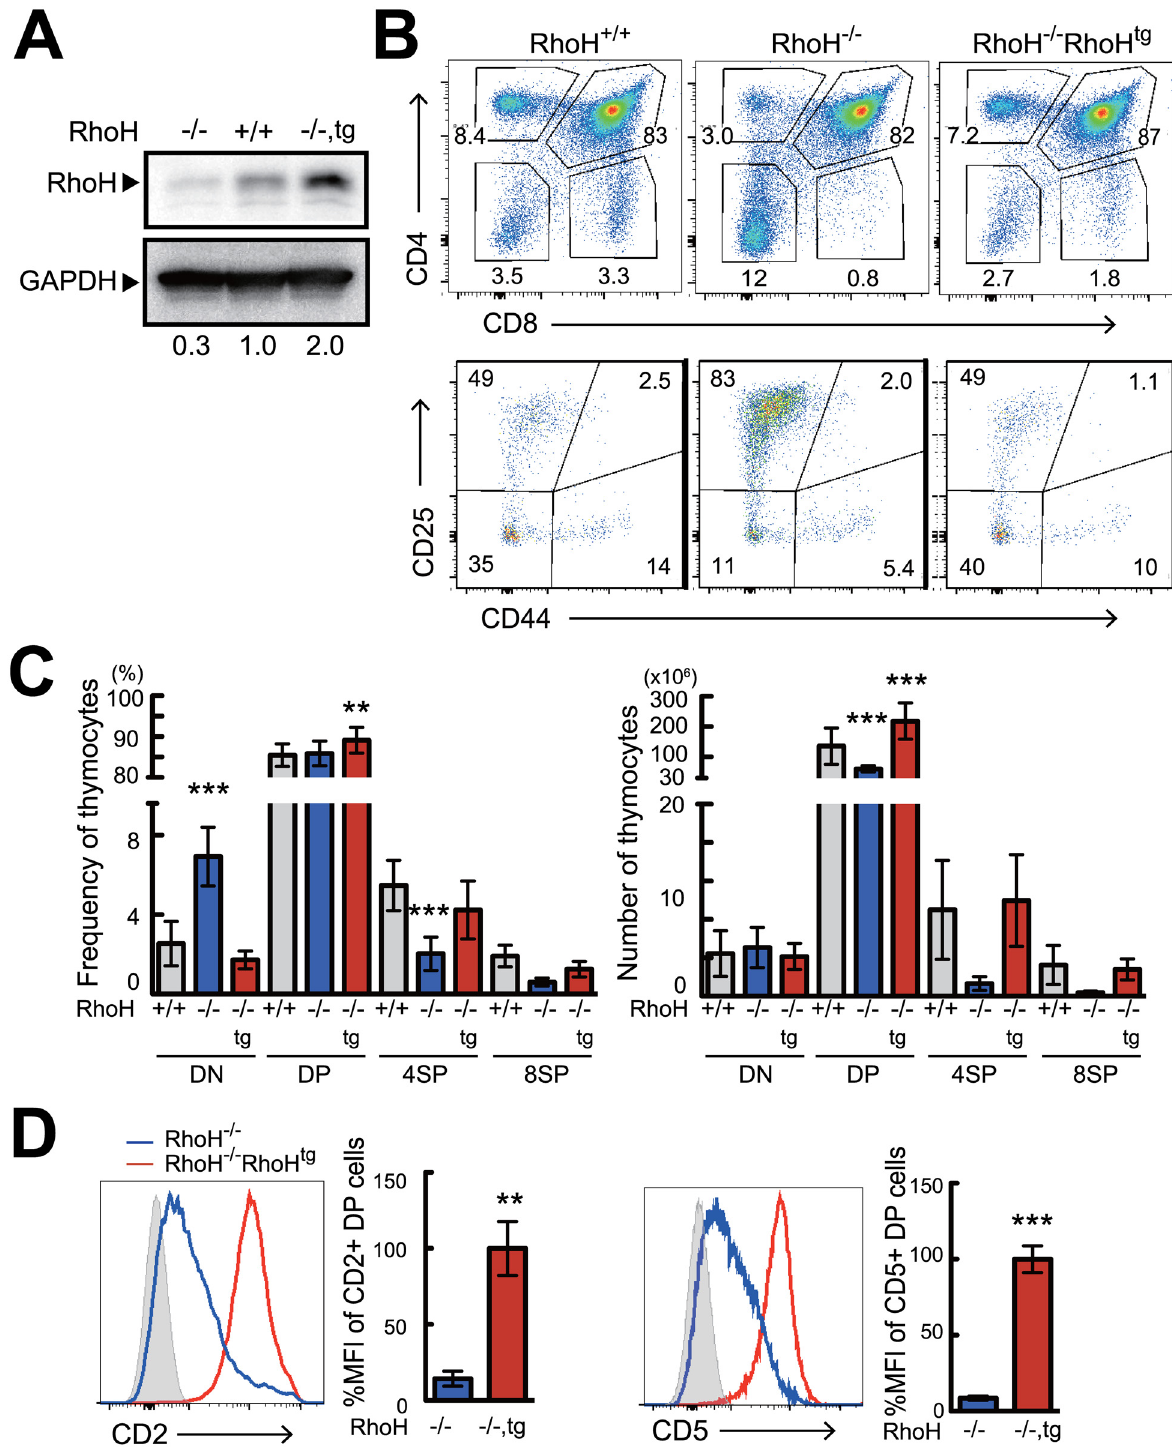
Fig 1. The transgenically expressed HA-tagged RhoH is capable of compensating T cell development in RhoH -/- mice. (A) Analysis of RhoH protein expression by western blot in RhoH -/- , RhoH -/- RhoH Tg , and RhoH +/+ thymocytes. (B, C) Analysis of RhoH -/- , RhoH -/- RhoH Tg , and RhoH +/+ thymocytes by flow cytometry. Two parameter plots show CD4 versus CD8 surface staining of thymocytes (upper), and CD25 versus CD44 surface staining on CD4 - CD8 - (DN) cells (lower). Numbers indicate percentage of cells in the selected area. Bar graphs represent average cell number and frequency of indicated thymocyte subsets calculated from six mice per group. (D) Single parameter histogram plots show CD2 and CD5 staining in DP thymocytes gated on CD4 + CD8 + cells (n = 6). Data are shown as mean +SD of more than four mice representative of independent experiments. * P < 0.05, ** P < 0.01, *** P < 0.001 doi:10.1371/journal.pone.0131047.g001 PLOS ONE | DOI:10.1371/journal.pone.0131047 June 26,